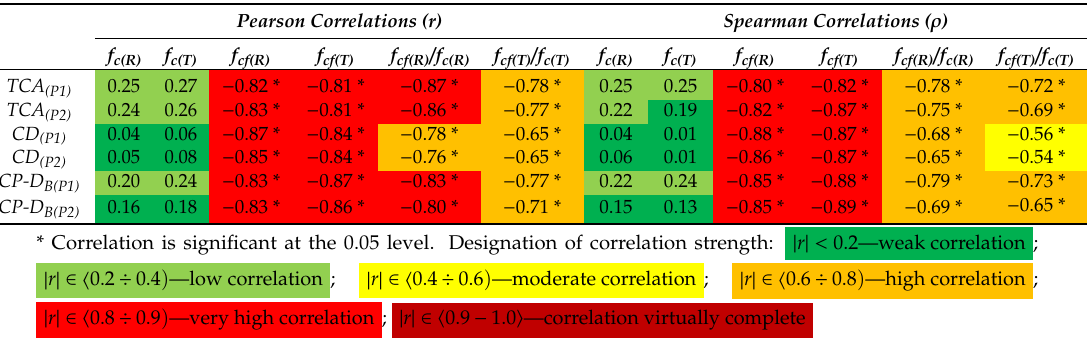
Table 4. Matrix of correlation coe ffi cients between the features describing the cracking patterns and the mechanical properties of the lime cement matrix. Pearson Correlations